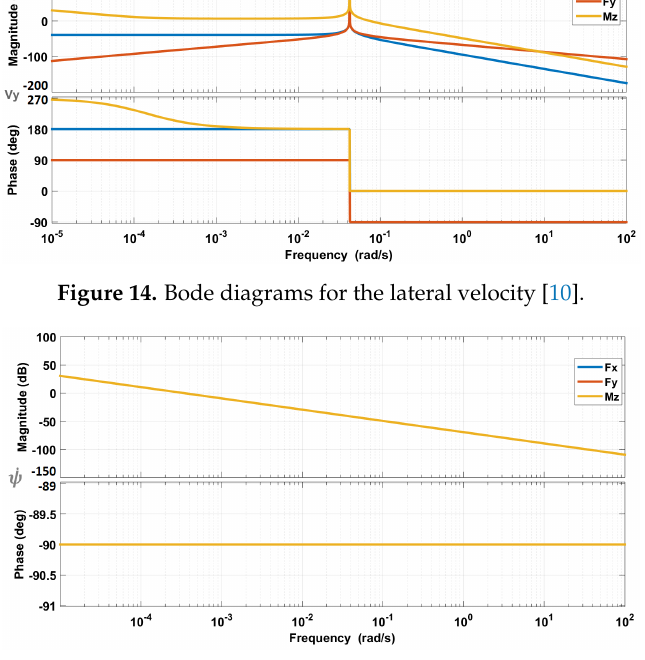
Figure 15. Bode diagrams for the yaw rate